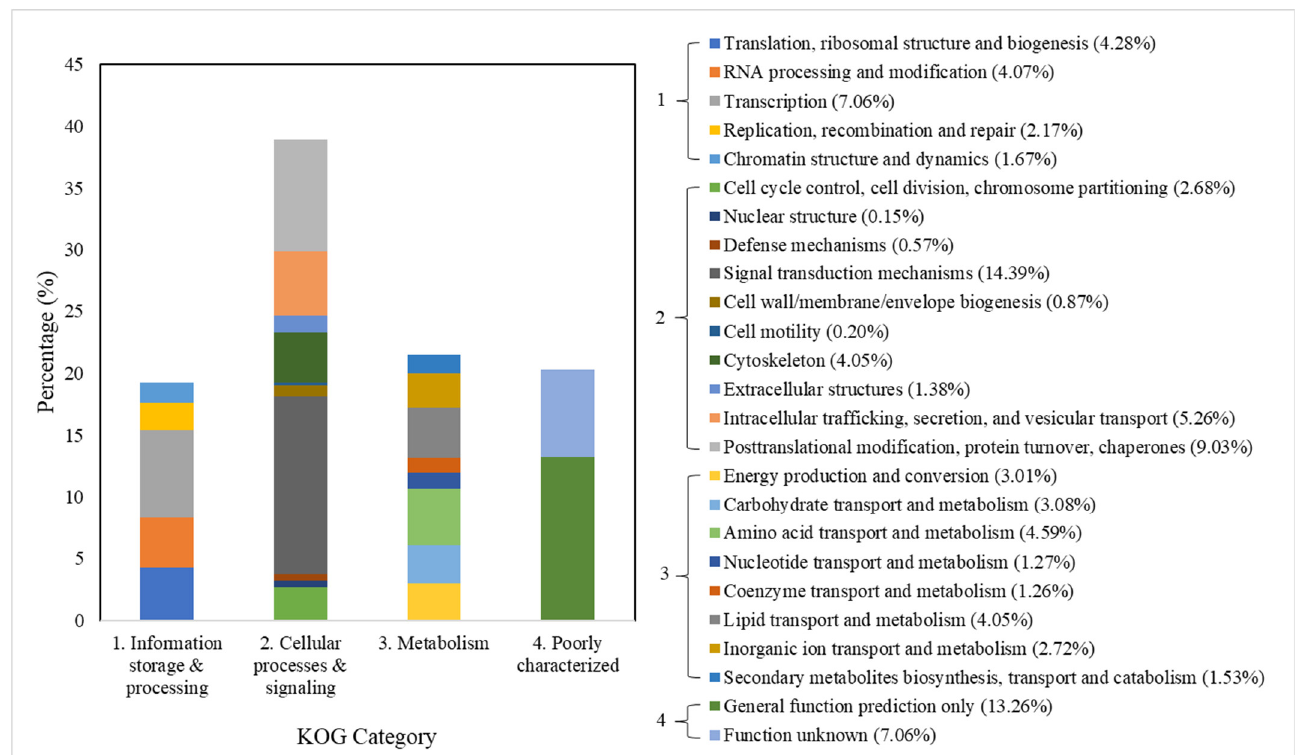
Figure 1. KOG gene function classification of the C. hemipterus unigenes.